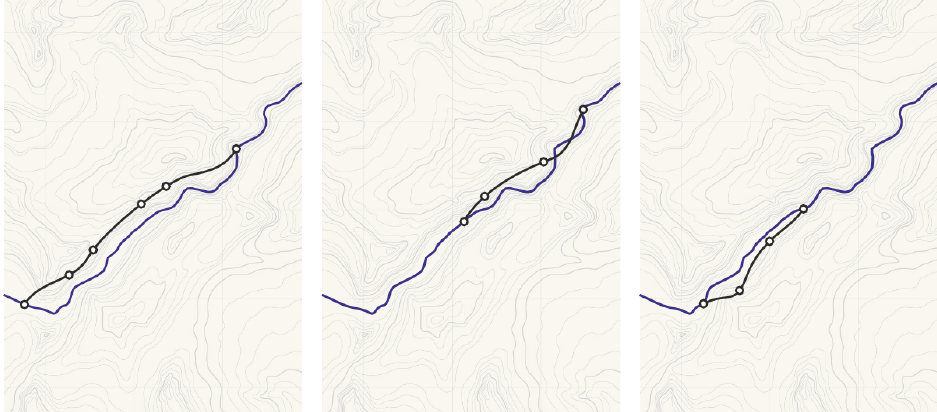
Figure 8. Example of three arbitrary individuals (black line) created for the given terrain (river is represented in blue). Note how each individual can be created with a different number of nodes.